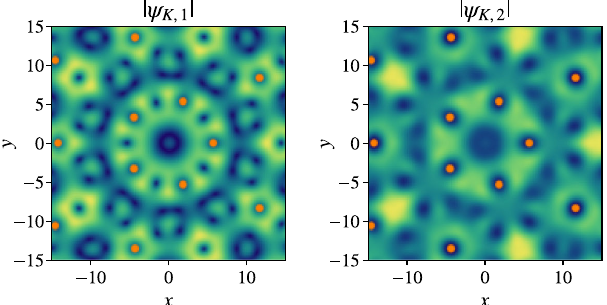
in the chiral C 5 -symmetric K